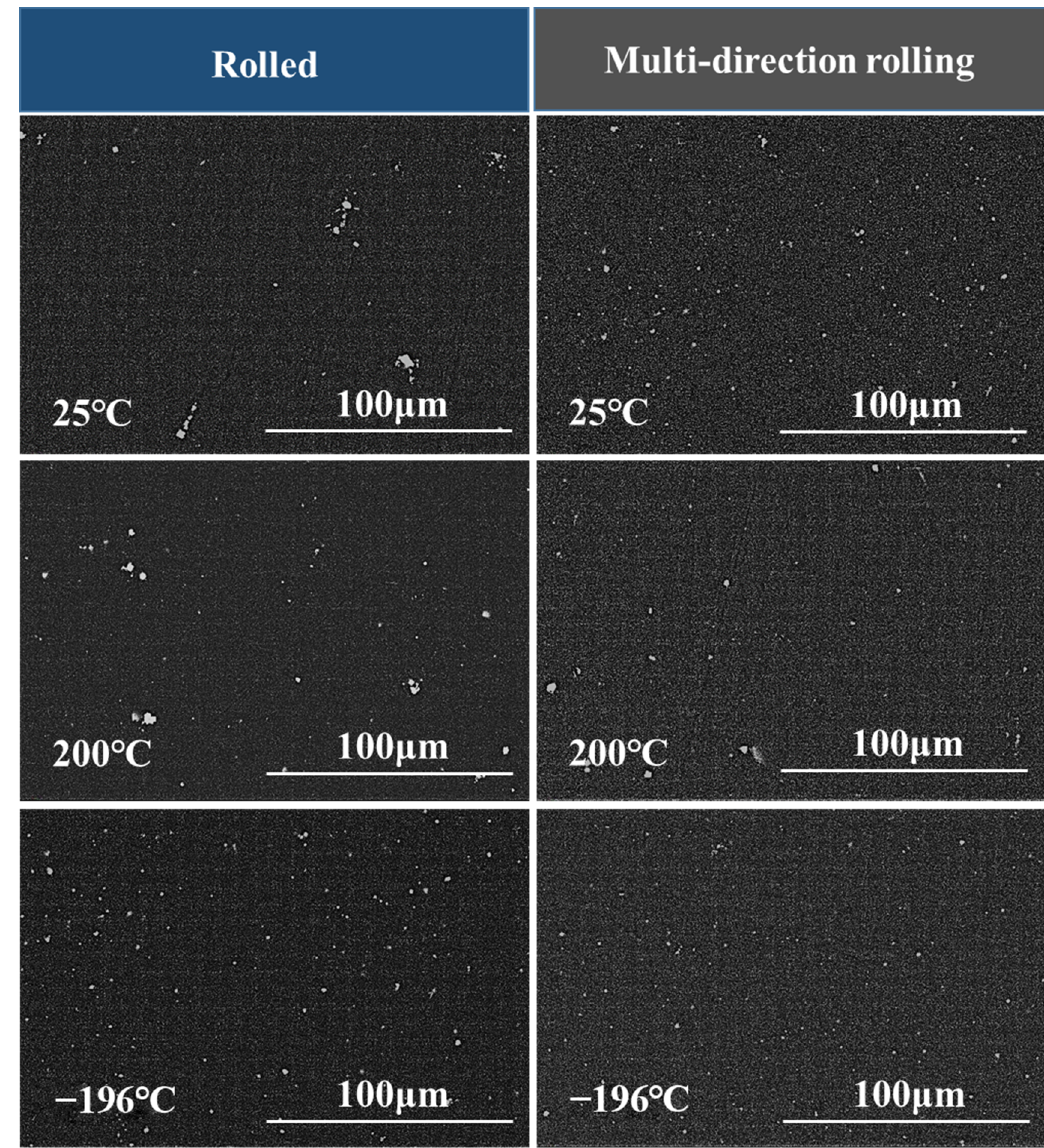
Figure 3. SEM images of the fragmentized primary second phase under various circumstances.